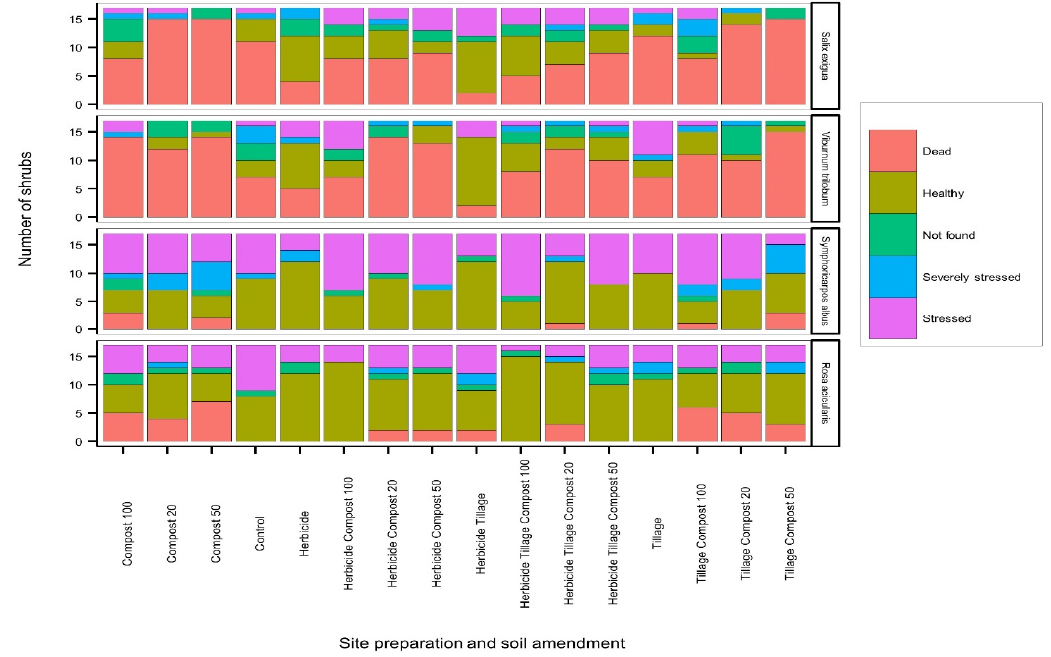
Figure 2. Number of individual shrub species by health categories based on site preparations and soil